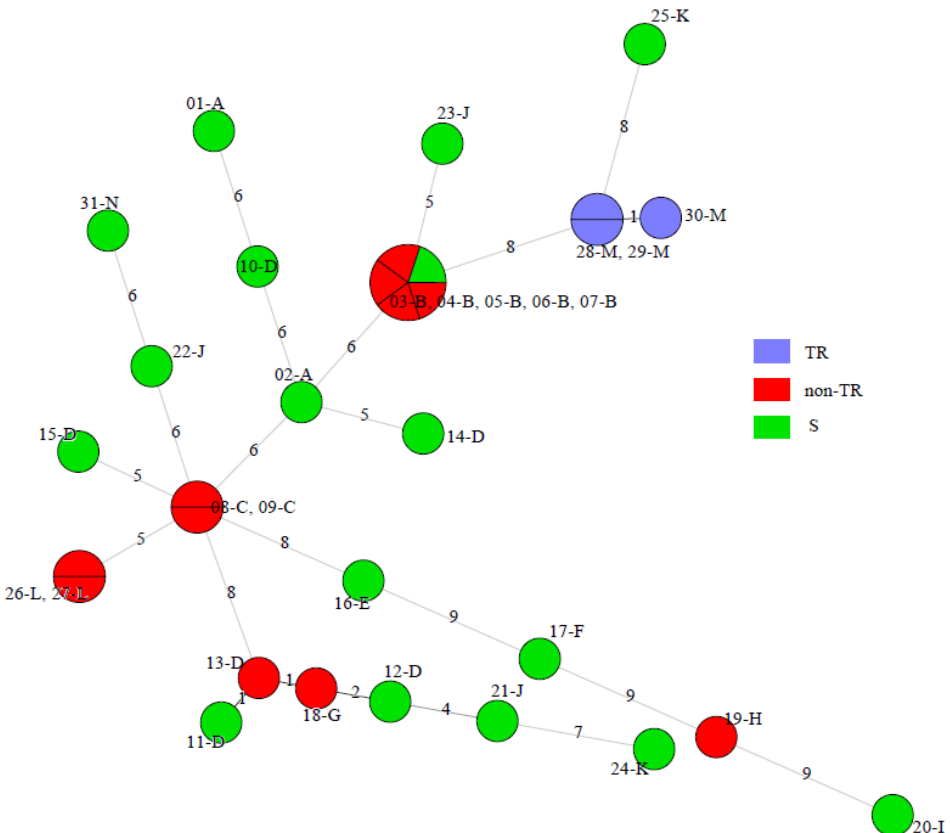
Figure 2. Minimum spanning tree of 29 clinical and 2 reference A. fumigatus isolates generated by considering the combined nSTRA f and TRESPERG data. Each circle shows a unique genotype. The different colours of the circles indicate the cyp51A modifications, grouped as triazole-susceptible (S), triazole-resistant with tandem repeats (TR), and triazole-resistant with nonsynonymous cyp51A mutations (non-TR).